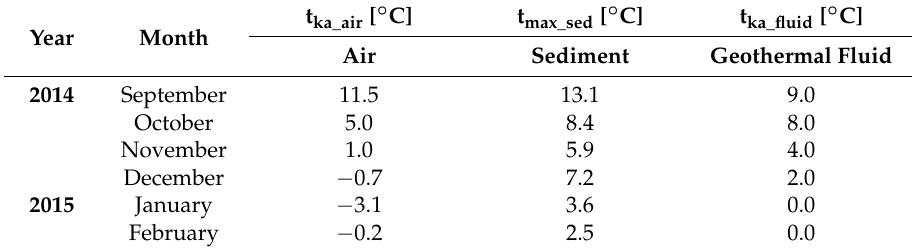
Table 3. The monthly mean air temperature (t ka_air ), the maximum sediment temperatures (t max_sed ) and the geothermal fluid temperatures (t ka_fluid ) in Vaasa in the measurement period 2014–2015.